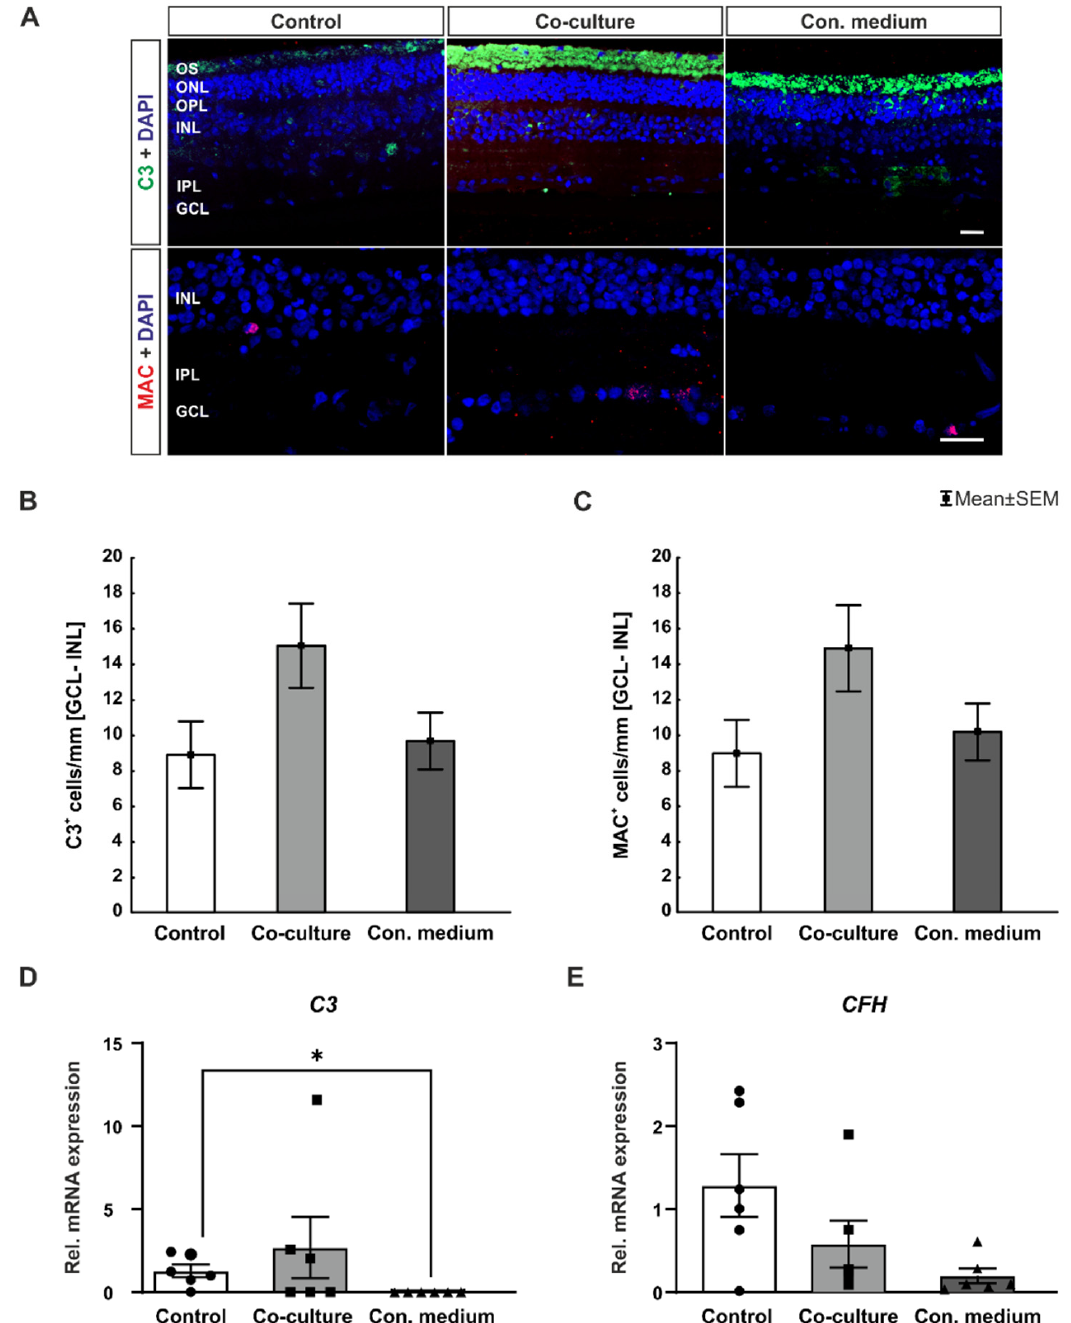
Figure 6. Unaltered complement activity. ( A ) To evaluate the complement factors, complement component 3 (C3, green) and the membrane attack complex (MAC, red) were labelled. Cell nuclei were marked with DAPI (blue). ( B ) The number of C3 + cells was comparable in the GCL–INL in all groups. ( C ) No differences were noted regarding MAC + cell numbers in GCL–INL in all groups. ( D ) Relative mRNA expression of C3 was significantly decreased in the conditioned medium group compared to control ( p = 0.021). ( E ) Relative mRNA expression of CFH showed no significant differences between groups. OS, photoreceptor outer segments; ONL, outer nuclear layer; OPL, outer plexiform layer; INL, inner nuclear layer; IPL, inner plexiform layer; GCL, ganglion cell layer. Scale bars: 20 µm, values are presented as mean ± SEM, ( A – C ) n = 8/group, ( D – E ) n = 6/group, * p < 0.05.